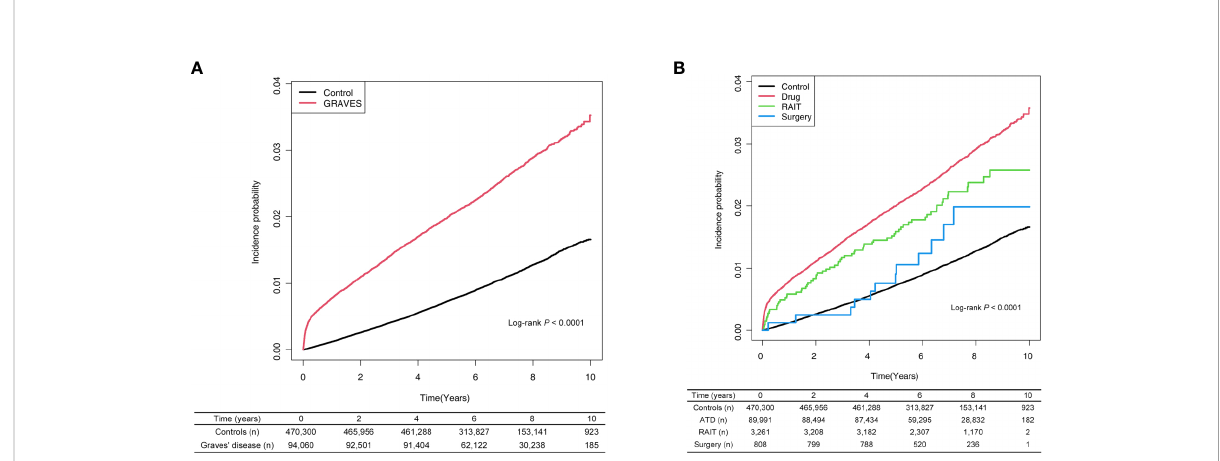
FIGURE 1 (A) Risk of atrial fi brillation among patients with Graves ’ disease and controls. (B) Risk of atrial fi brillation among patients with Graves ’ disease according to treatment modality. ATD, anti-thyroid drug; RAIT, radioactive iodine therapy.